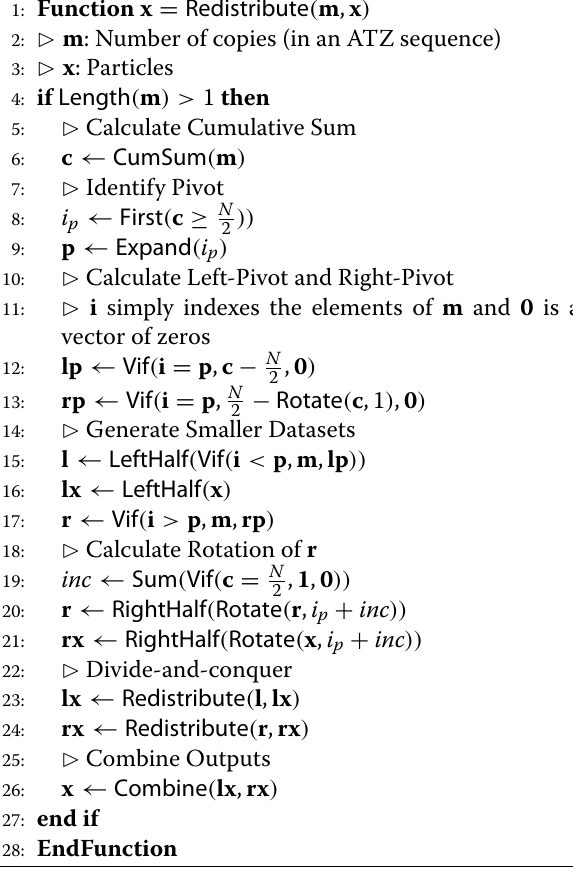
Algorithm 3 Redistribute: O tion.